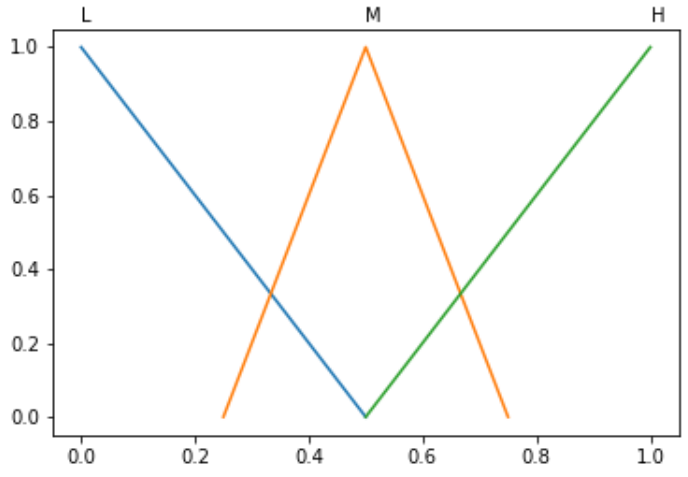
Figure 4. Fuzzy sets for the customer i